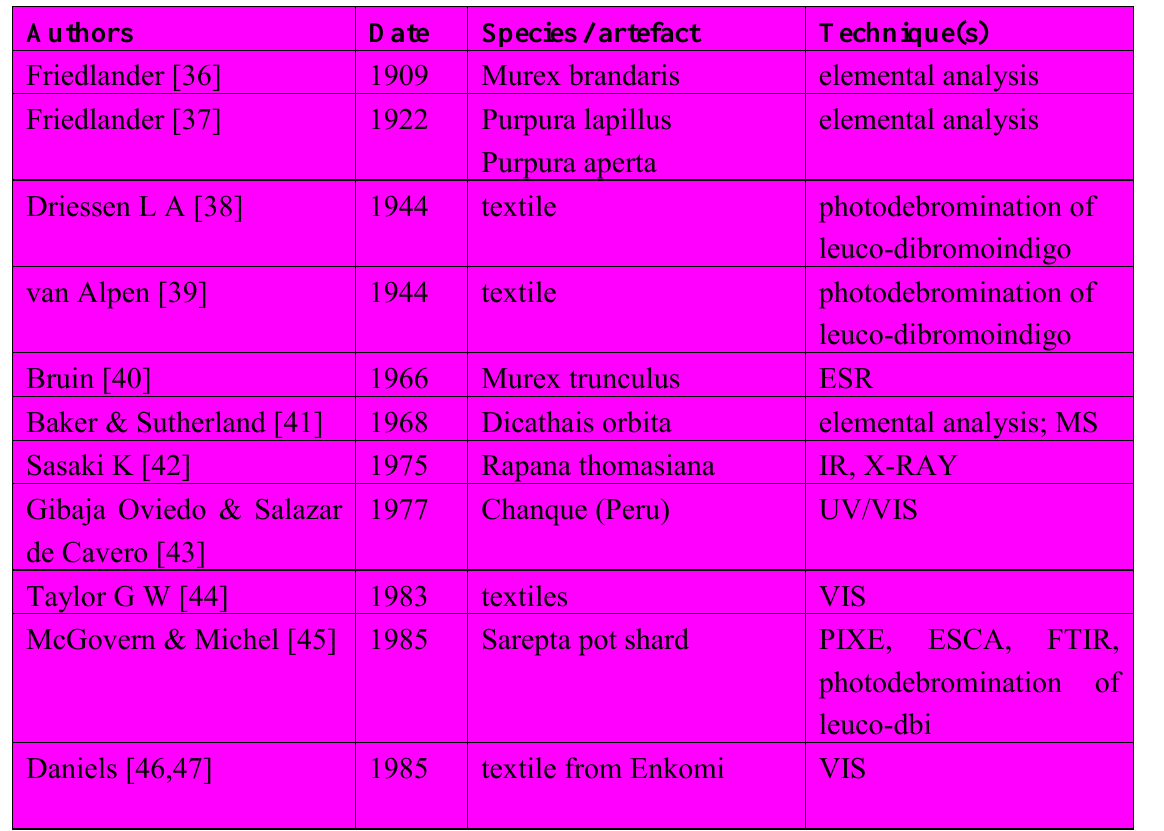
Table 1. Methods used to identify dibromoindigo in molluscs and on